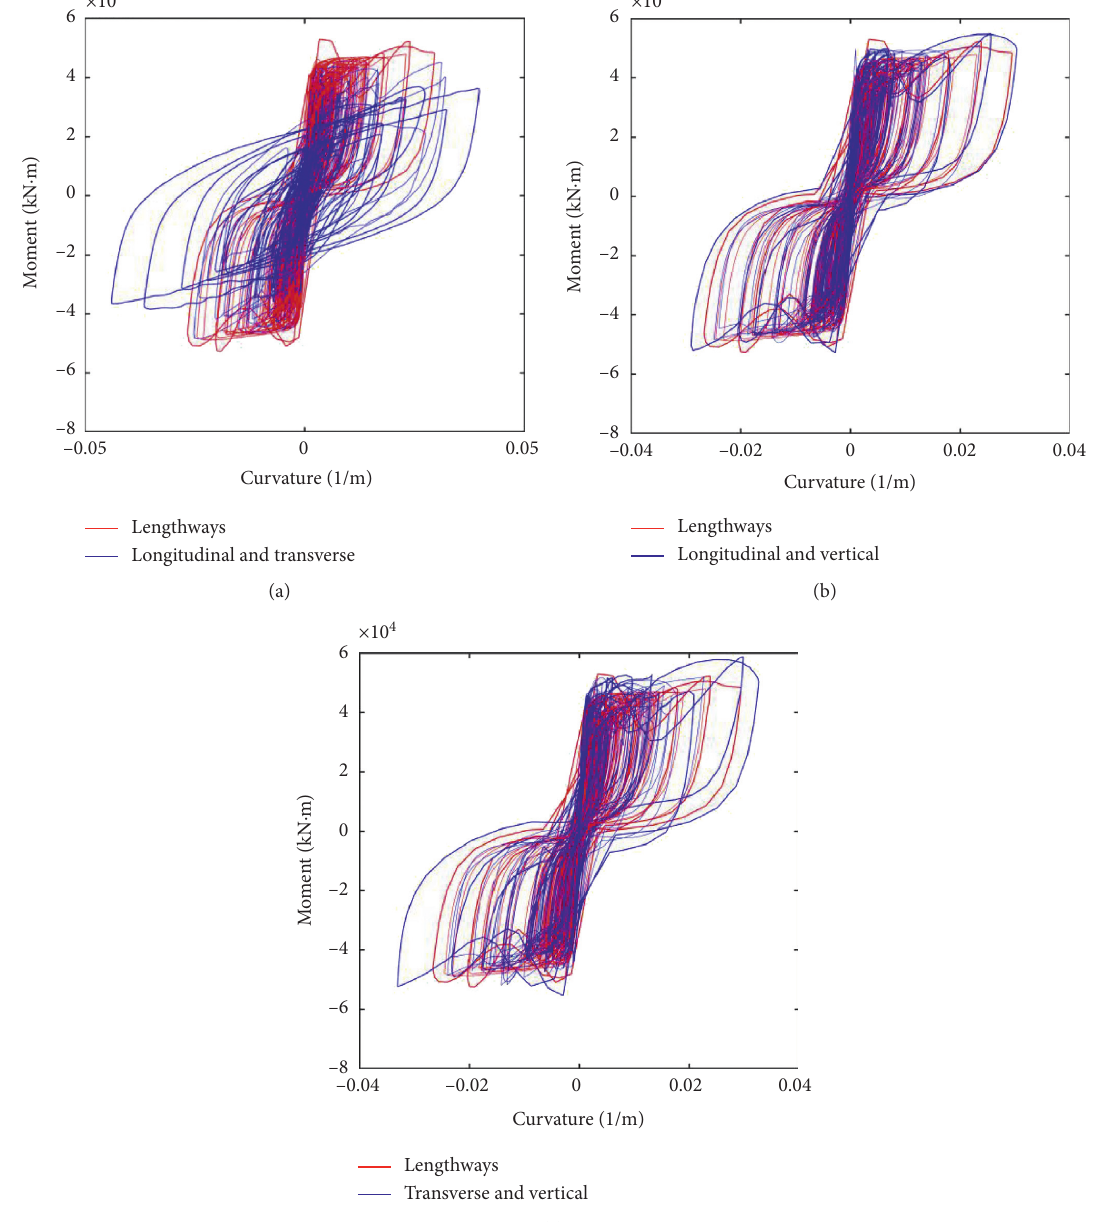
Figure 3: Moment-curvature curves of 10 waves at the pier bottom: (a) longitudinal and lateral simultaneous action; (b) vertical and longitudinal simultaneous action; (c) transverse and vertical simultaneous